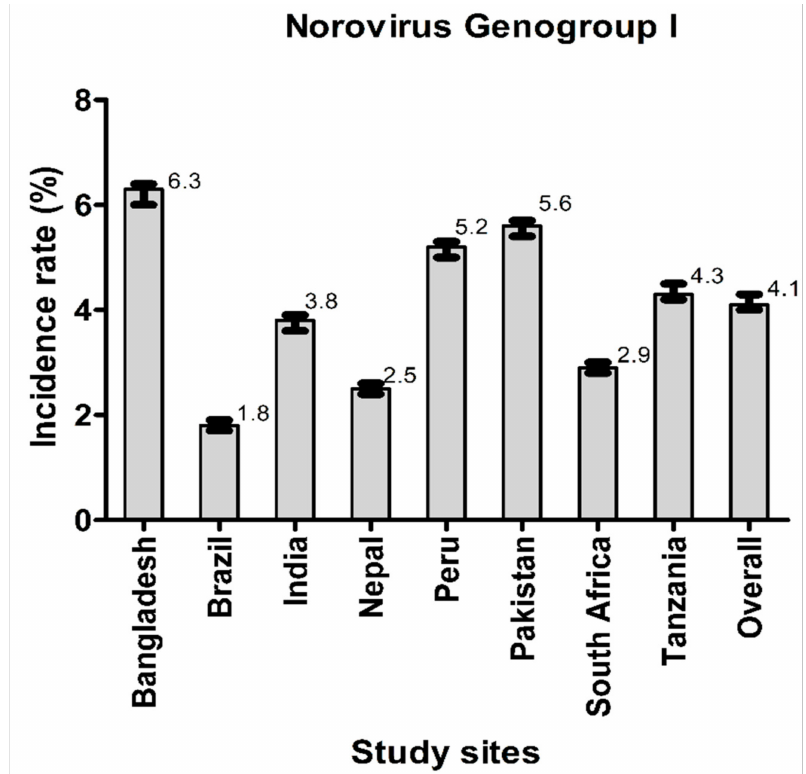
Figure 2. Incidence rates of norovirus GI infections.